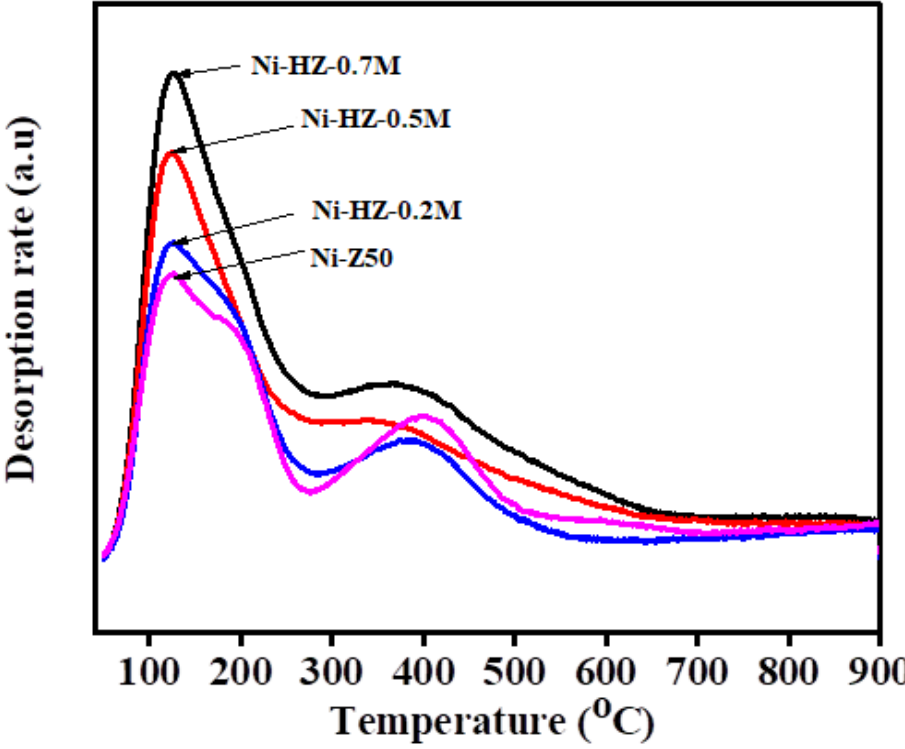
Figure 7. Ammonia TPD analysis of nickel-supported hierarchical zeolite samples.